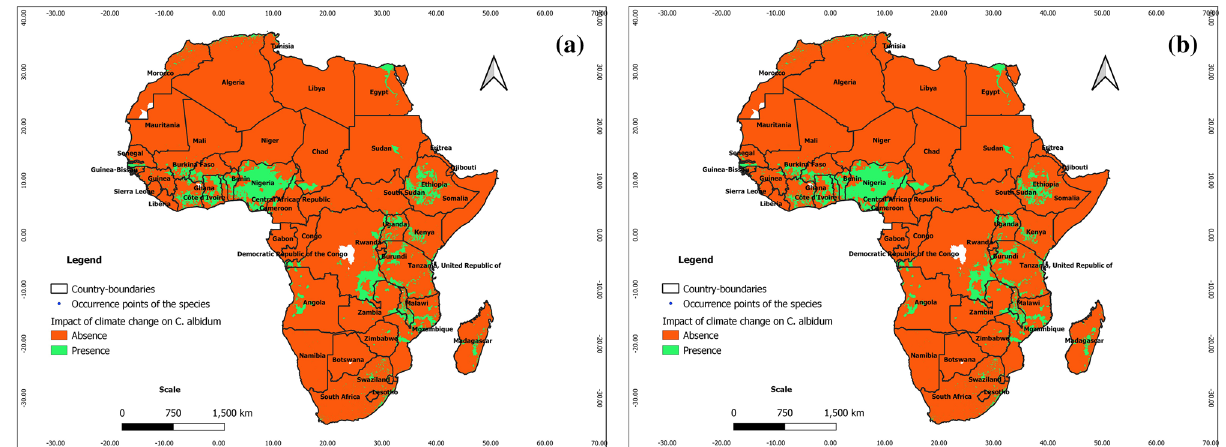
Figure 12. Comparison of predictions under Africlim and MIROCES2L according to Maxent: a) extension of favorable area of the species under Africlim rcp 4.5 horizon 2055 with respect to MIROCES2L SSP245 horizon 2060; b) extension of favorable area under Africlim rcp 8.5 horizon 2055 with respect to MIROCES2L SSP585 horizon 2060 (the maps were generated using R version 4.1.3 (https:// www.R- proje ct. org/), QGIS 3.18.1 (http:// qgis. osgeo. org), and WGS 84 as Coordinate Reference